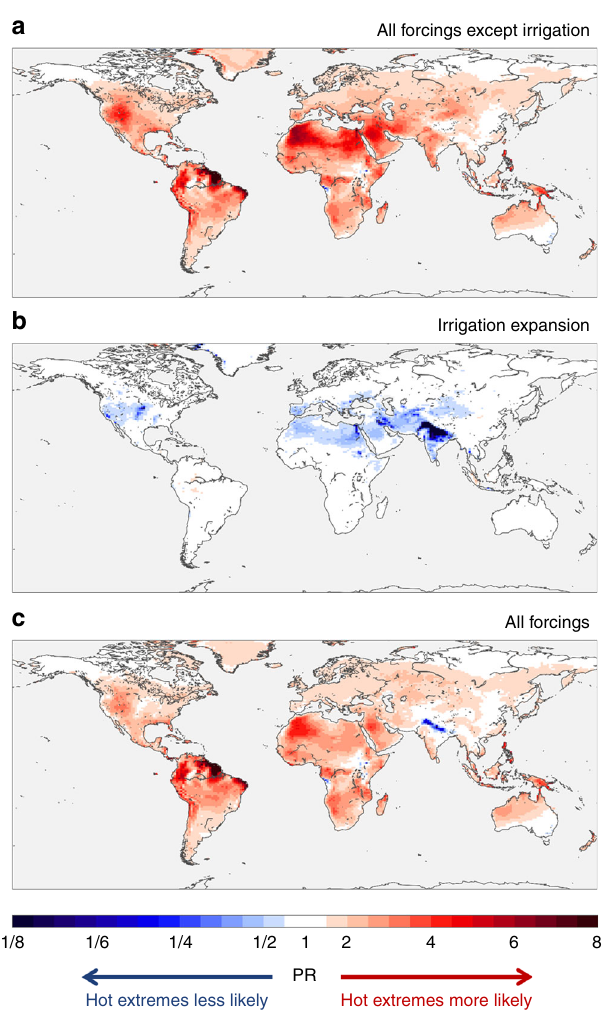
Fig. 2 Change in probability of hot extremes from expanding irrigation and other forcings. Ensemble-mean likelihood of exceeding 99th percentile of daytime temperature ( TX ) as simulated by CESM, considering all forcings except irrigation ( a ), irrigation expansion only ( b ), and all forcings including irrigation expansion ( c ). Probability ratios (PRs) are shown for the present-day (1981 – 2010) relative to the early 20th century reference period (1901 – 1930), except for b where the reference is a counter-factual present- day world without